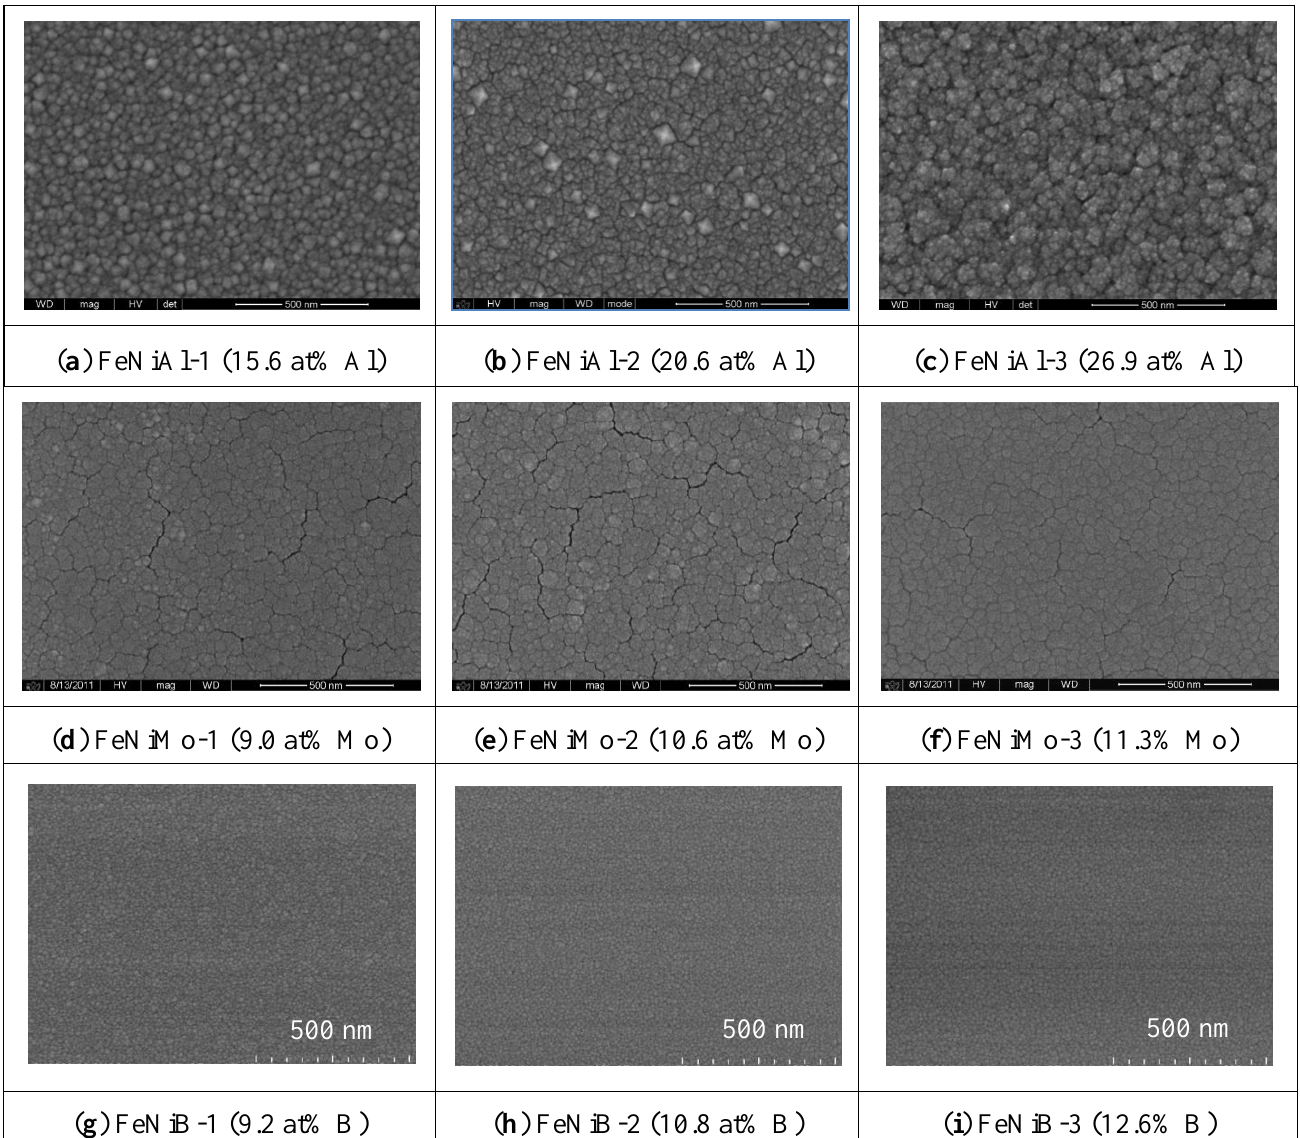
Figure 1. SEM images of the surface morphology evolutions of FeNiAl, FeNiMo and FeNiB with various Al, Mo and B